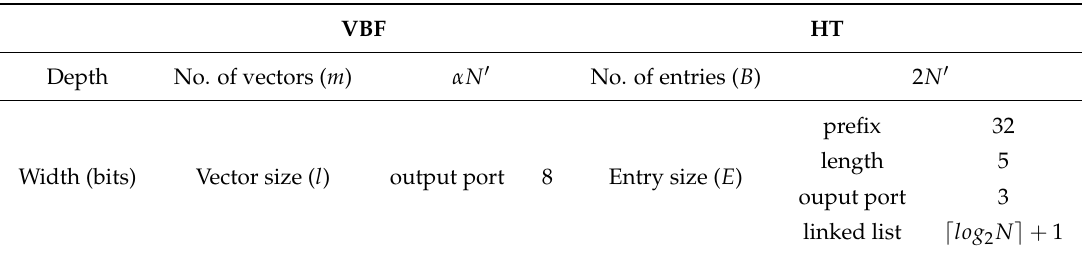
Table 1. Data structures.